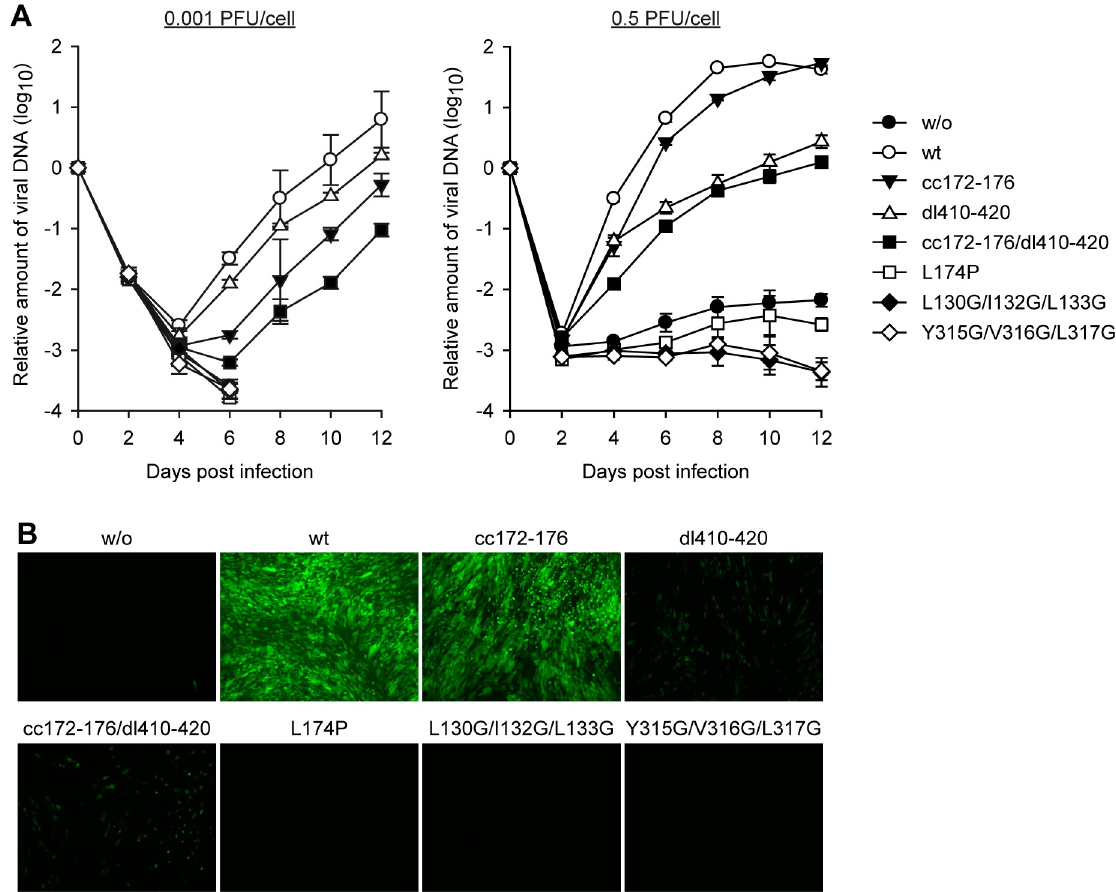
Fig 8. Compensation by IE1cc172-176 for wild-type IE1 in hCMV replication. (A) TetOne cells (w/o) and TetOne-IE1 cells expressing the indicated HA-tagged wild-type (wt) or mutant IE1 proteins were infected with gTBdlIE1 at an MOI of 0.001 PFU/cell (left panel) or 0.5 PFU/cell (right panel). Every 48 h, half of the culture media was replaced and viral replication was assessed by qPCR-based relative quantification of hCMV DNA from culture supernatants with primers specific for UL86. Data are presented as means and standard deviations from three independent infections. (B) TetOne cells (w/o) and TetOne-IE1 cells expressing the indicated HA-tagged wild-type (wt) or mutant IE1 proteins were infected with gTBdlIE1 at an MOI of 0.5 PFU/cell as described in (A), and viral replication was assessed at day 8 post infection by fluorescence microscopy (EVOS FL Cell Imaging System, 4 ×